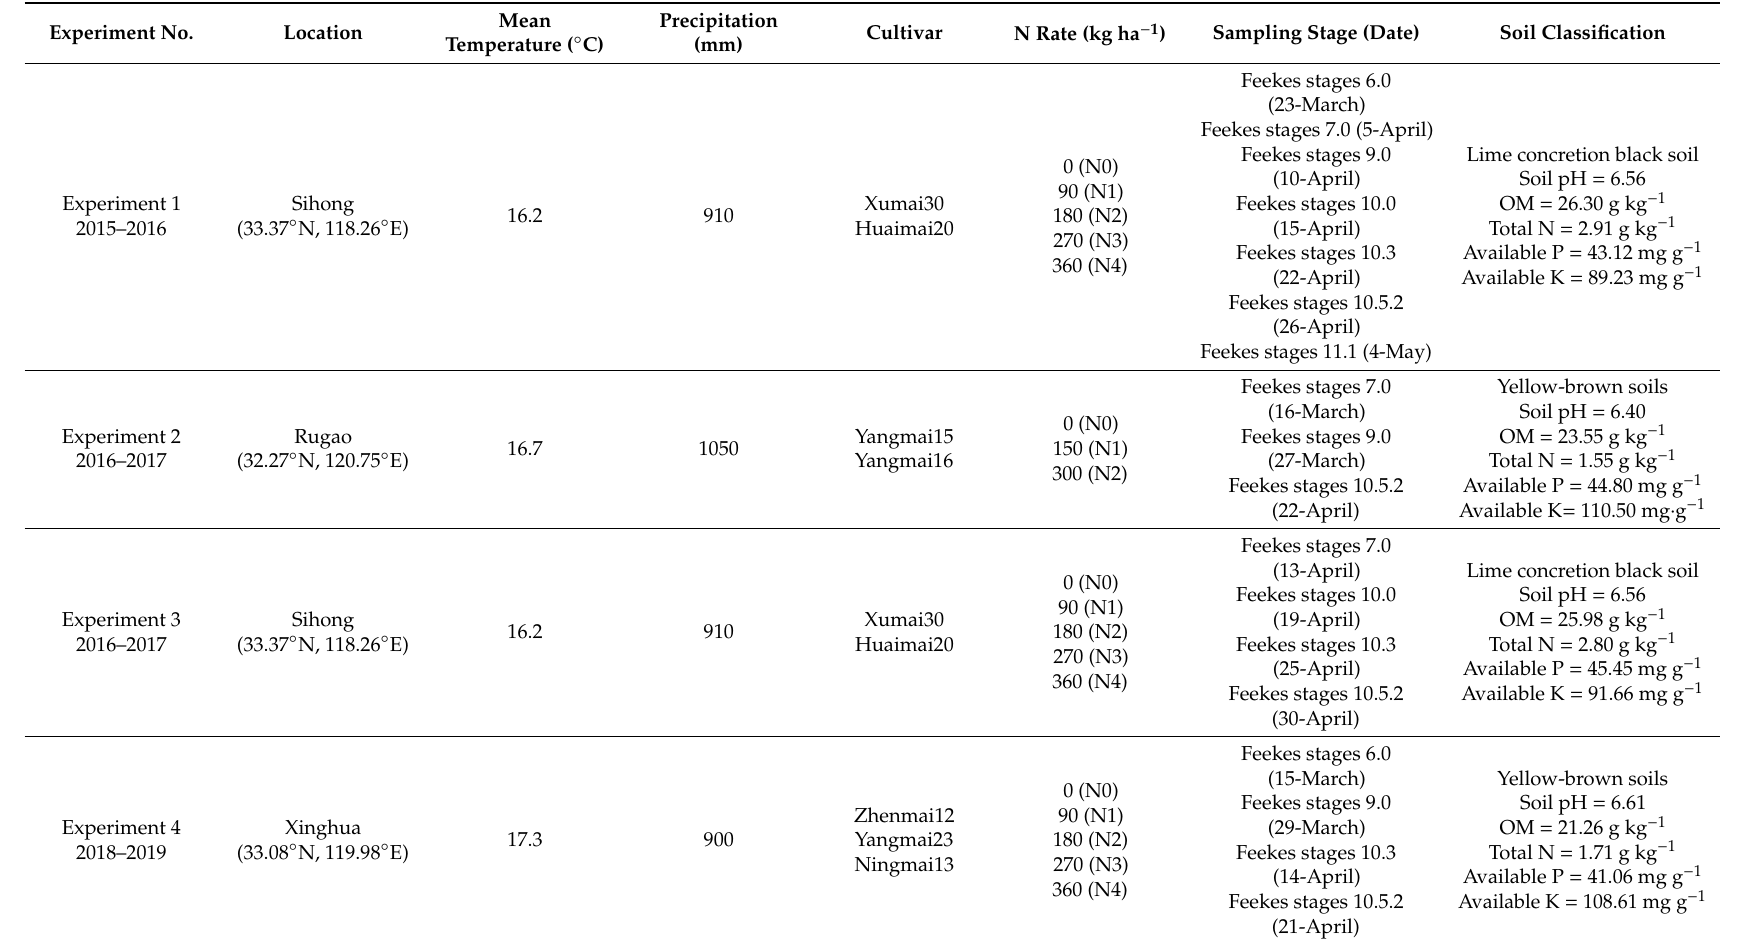
Table 1. Description of the field experimental